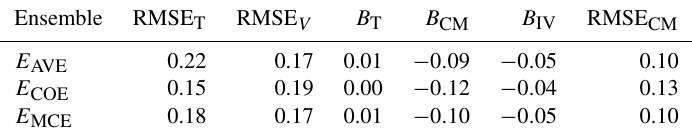
Figure 3. CMIP5 data properties. (a) Model outputs and observations. (b) Model output distribution. (c) AVE, COE and MCE weights. Table 3. Performance comparison of different methods on CMIP5 data; RMSE on training (RMSE T ) and validation (RMSE V ) data; and trend bias ( B T ), climatological monthly bias ( B CM ), interannual variability bias ( B IV ) and climatological monthly RMSE (RMSE CM ) on validation data.